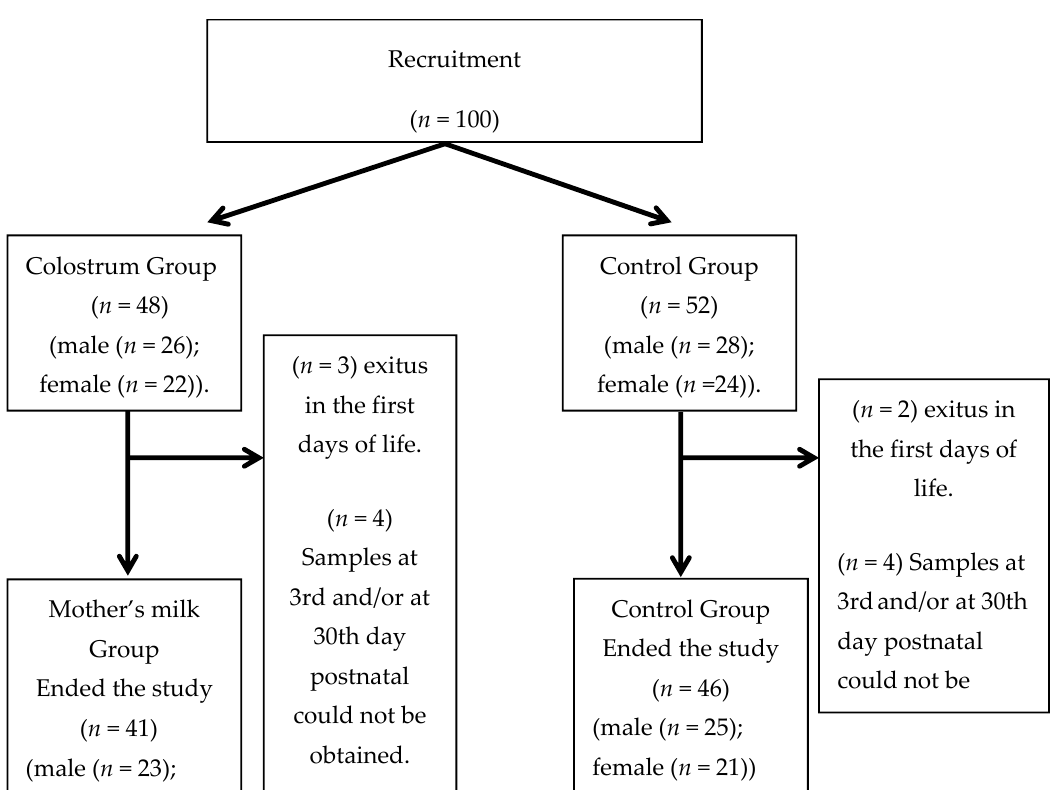
Figure 1. Flowchart showing participant progress and dropouts in the study.